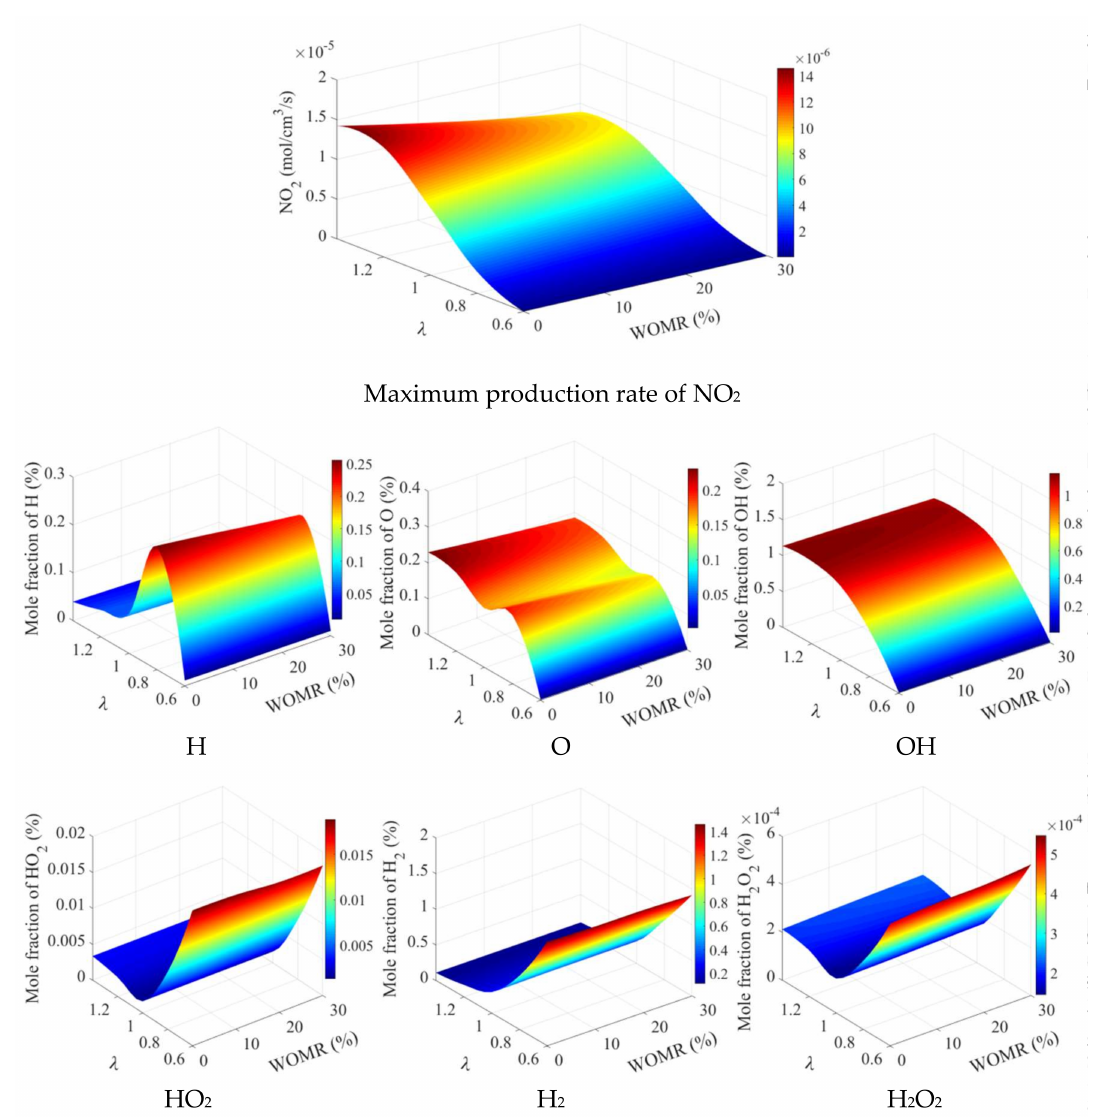
Figure 7. Mole fraction of free radicals corresponding to maximum rate of production of NO 2